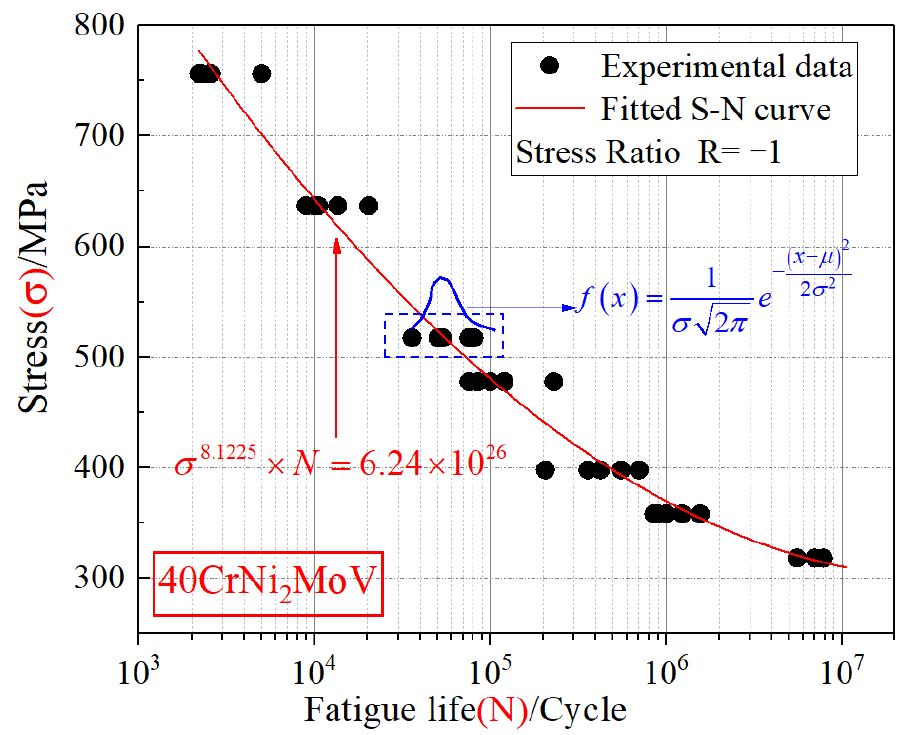
Figure 13. Fatigue data and fitted S-N curve for the pumphead material.